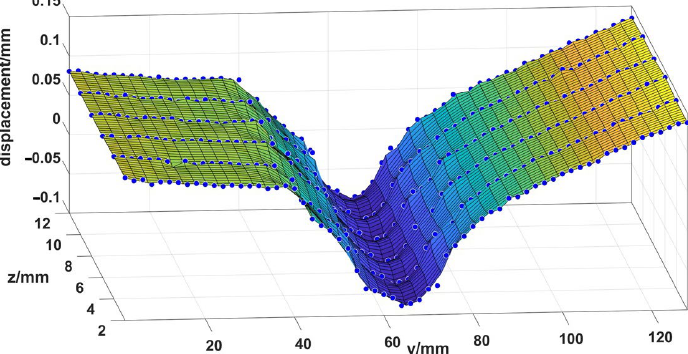
Figure 15. Displacement of the cutting surface under initial welding parameters.